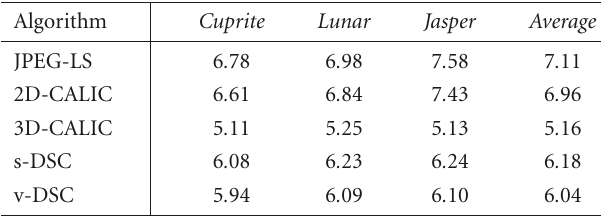
Table 2: Coding e ffi ciency of the adaptive DSC coders compared to that of conventional 2D and 3D schemes.